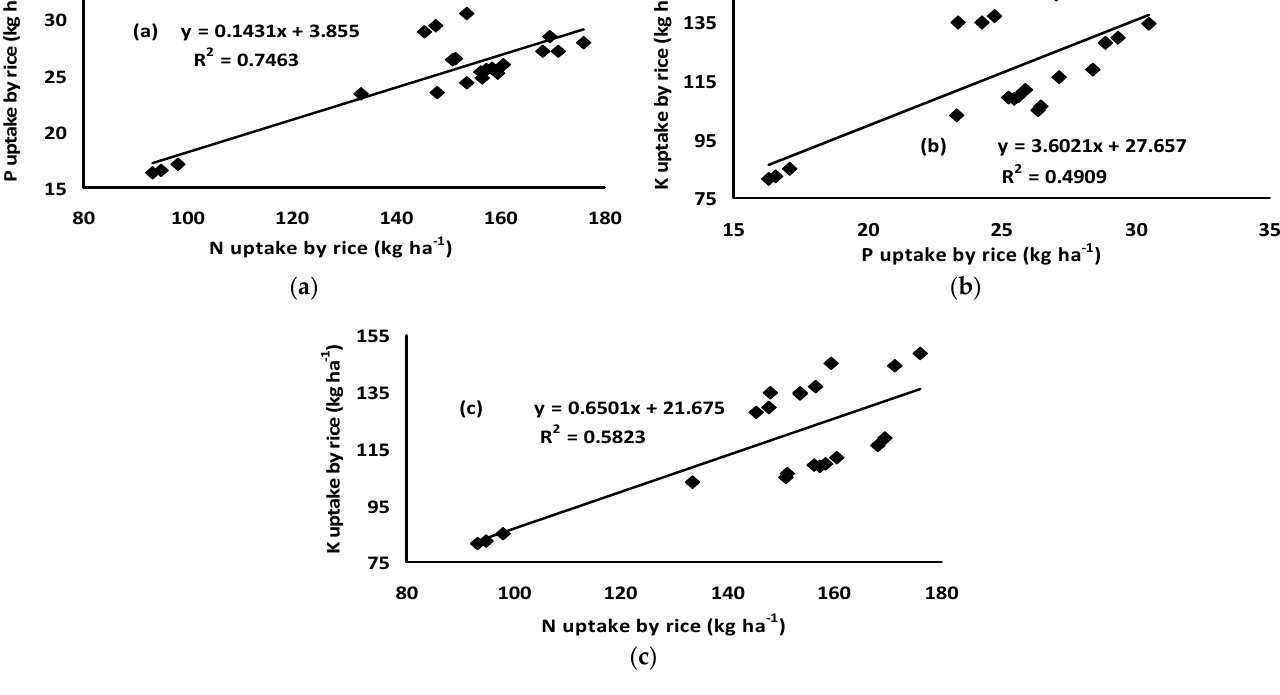
Figure 1. Relationship between the different nutrients uptake by rice: ( a ) N & P, ( b ) P & K, and ( c ) N & K uptake by rice.